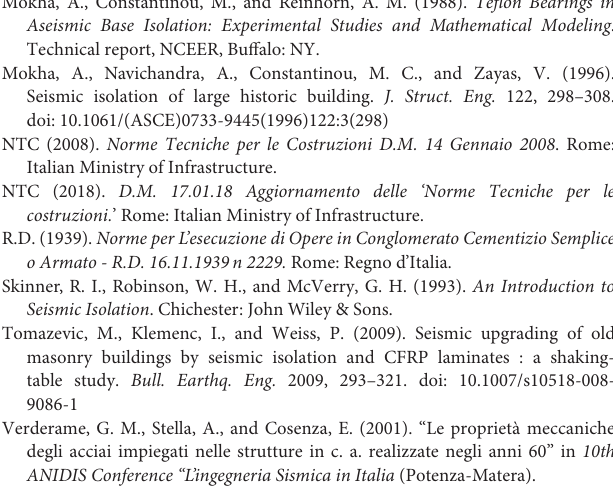
table study. Bull. Earthq. Eng. 2009, 293–321. doi: 10.1007/s10518-008-